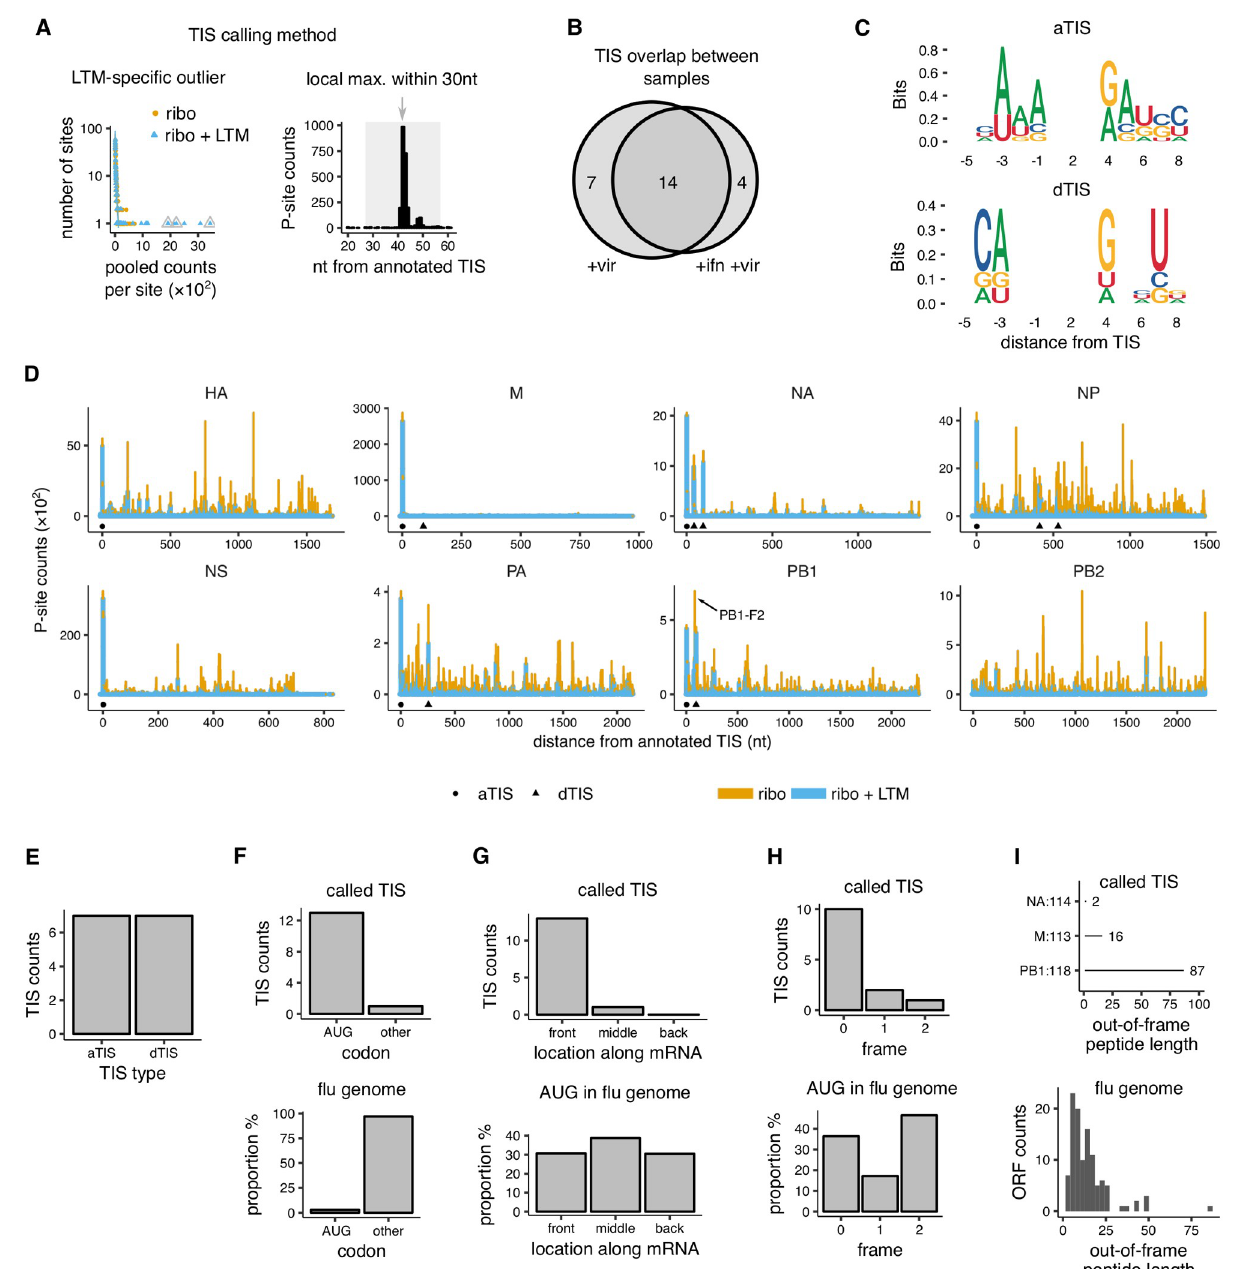
Fig 3. Candidate translation initiation sites on influenza transcripts. (A) Method for identifying candidate translation initiation sites (TIS) in influenza. Left panel: LTM-specific outliers were identified over the background of Ribo-seq and Ribo-seq + LTM pooled counts at each site of each influenza transcript. Right-panel: Among LTM-specific outliers, only the highest LTM peak in P-site counts within each 30 nucleotide window was called as start site. The background Ribo-seq and Ribo-seq + LTM counts were fit to separate zero-truncated negative binomial distributions (lines in left panel). The final called TIS are indicated by grey triangles and arrows. The left panel shows the NA segment of our +vir sample and the right panel a window around the NA43 TIS. See S8 Fig for other influenza segments. (B) Overlap in candidate TIS between the +vir and +ifn +vir samples. (C) Consensus motif of annotated translation initiation sites (aTIS, upper panel) and downstream translation initiation sites (dTIS, lower panel). (D) P-site counts from Ribo-seq and Ribo-seq + LTM assays are shown for all 8 influenza genome segments for our +vir sample. The counts from the two assays are shown as stacked bar graphs for ease of comparison. The candidate annotated TIS (circle) and downstream TIS (triangle) are indicated below the coverage plots. The known alternate initiation site PB1-F2 is highlighted with arrow. Note that the plot for NP shows the aggregated results over the two synonymously recoded NP variants; see Fig 4 for results broken down by NP variant. (E) Number of called annotated and downstream TIS. (F) Distribution of codon identity for candidate influenza TIS (top) and for all codons in influenza genome (bottom). Other indicates all non-AUG codons.